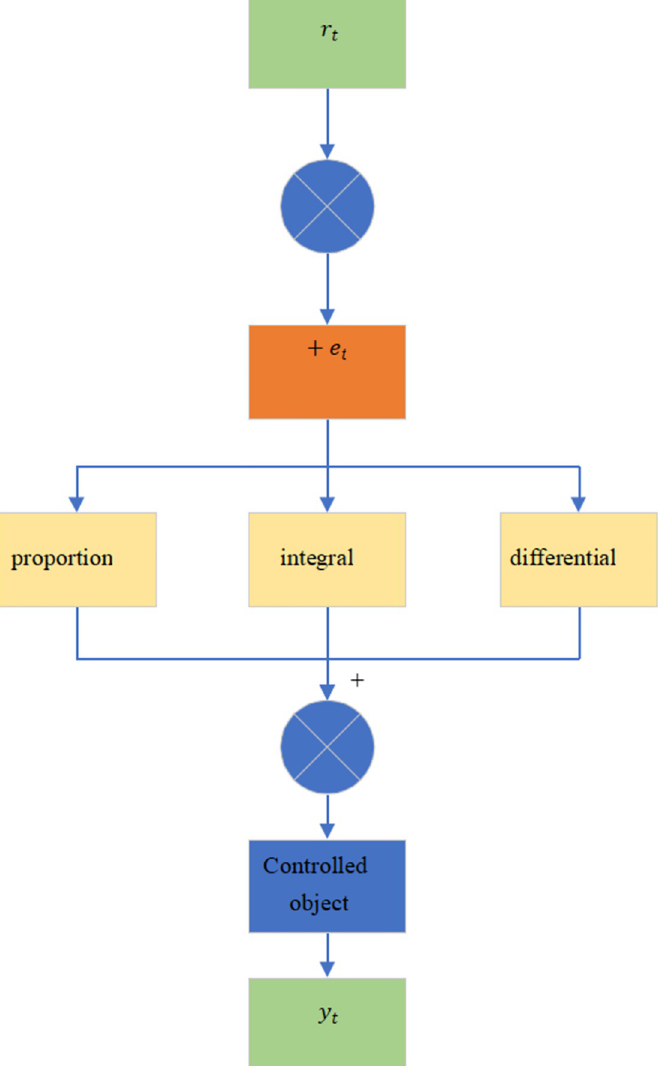
Fig 2. Fundamentals of the PID control